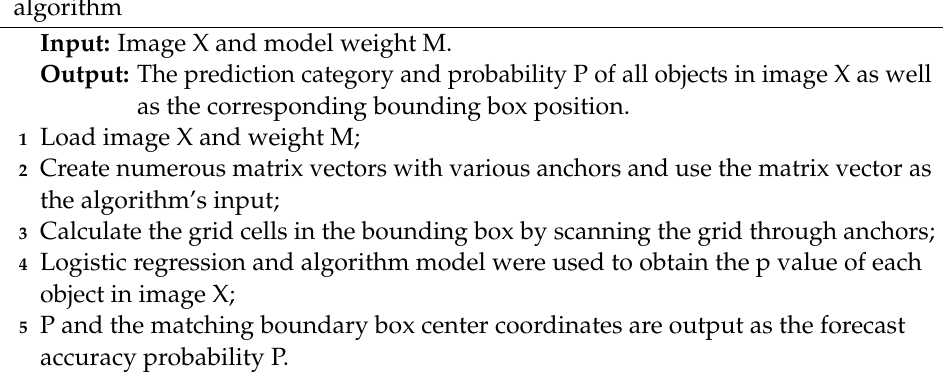
Figure 6. The prediction process of the improved YOLOv3 object detection; The input image is divided into an equal-sized s × s grids ( a ); each grid includes three different scales and each scale owns three bounding boxes with different sizes ( b , c ) to predict the object ( d ). Algorithm 2: The prediction process of the improved YOLOv3 object detection